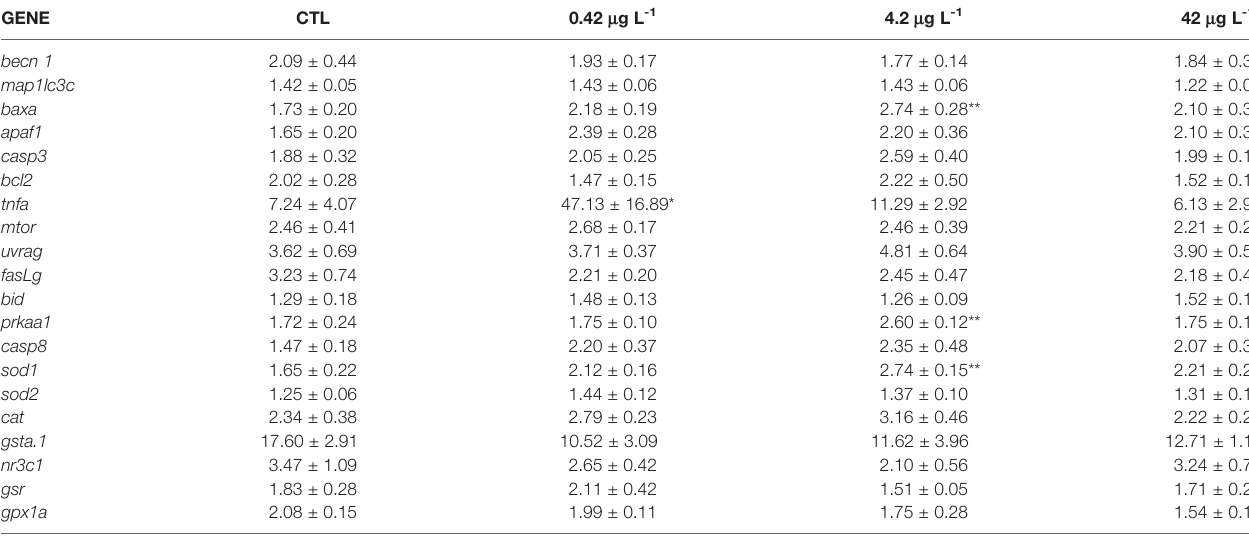
TABLE 2 | Transcriptional effects of DiNP on the zebra fi sh ovary.